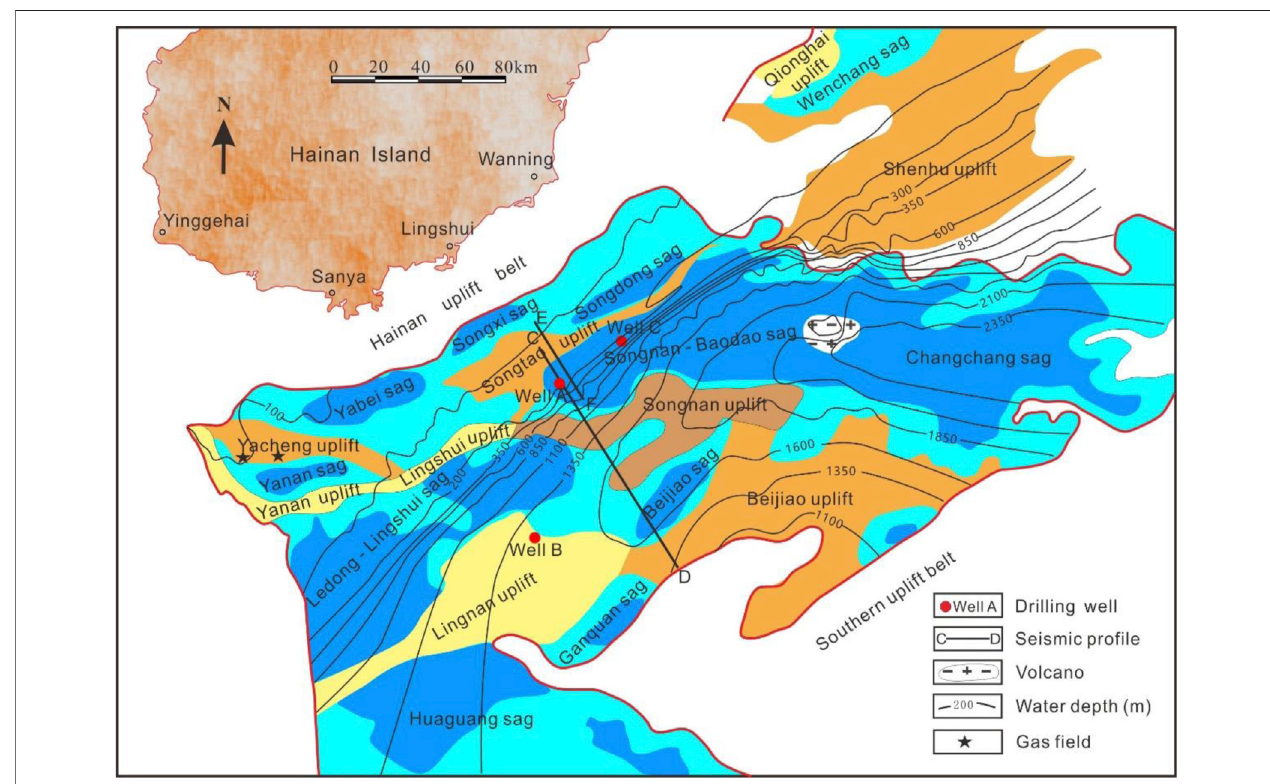
FIGURE 1 | Structural features of the Qiongdongnan Basin and the location of gas fi elds, wells, bathymetry and locations of seismic pro fi les (modi fi ed after Zhu, 2007). The units of bathymetry are in meters.